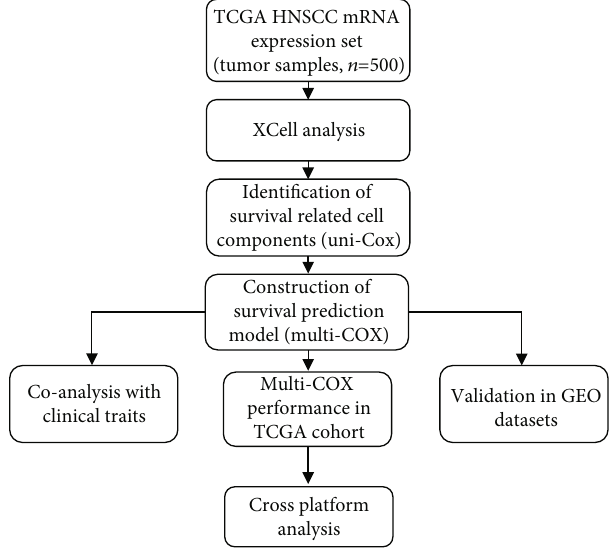
Figure 1: Work fl ow of the